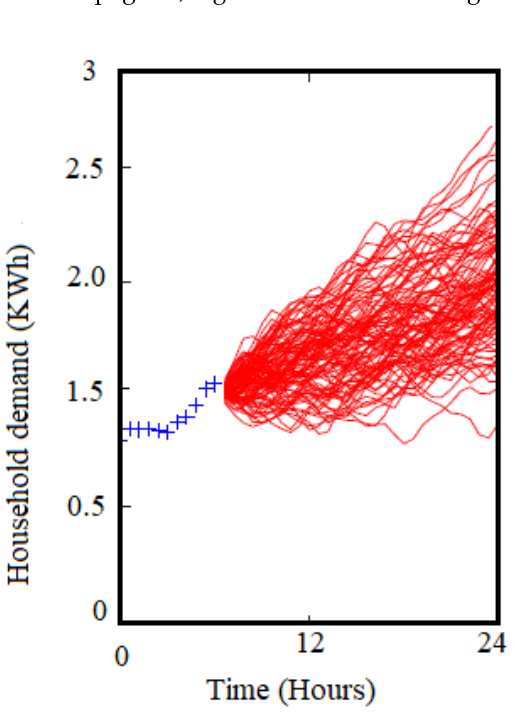
Figure 23. An example of the ensemble forecasts for household